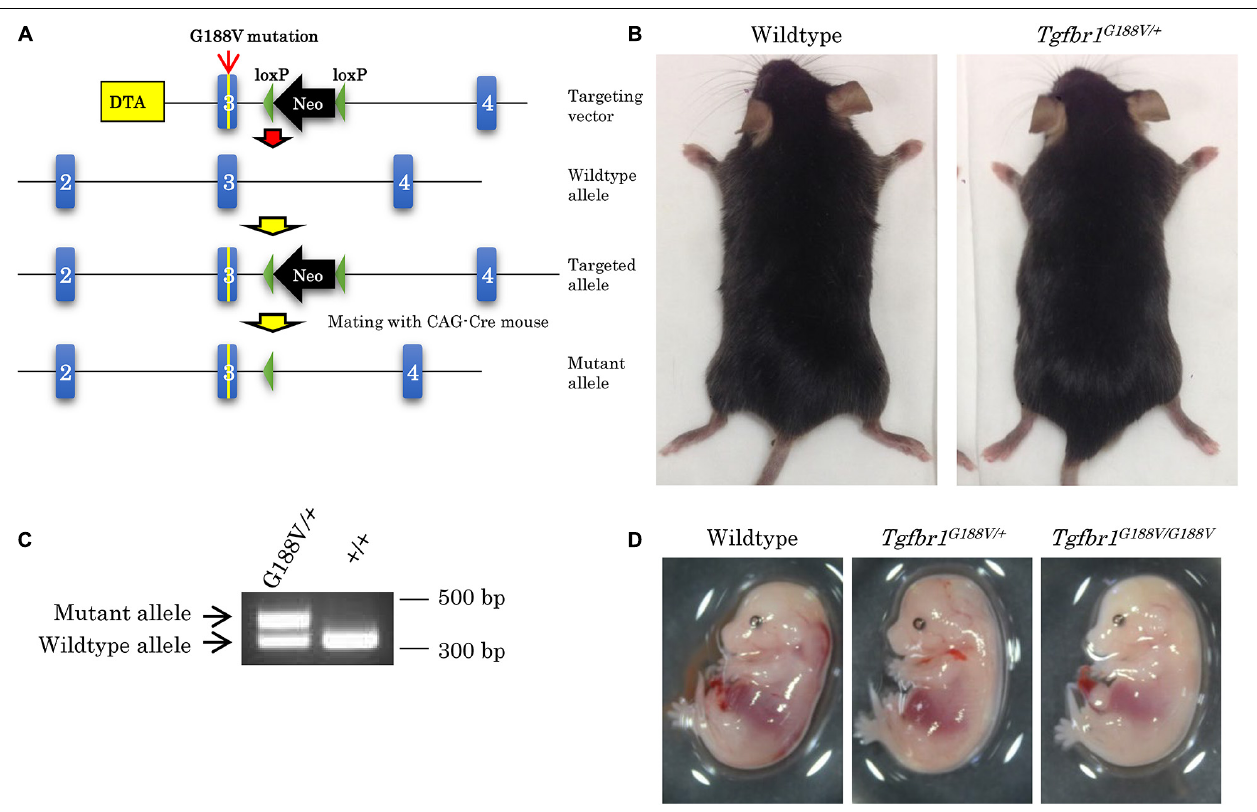
FIGURE 3 | Generation of knock-in mice with the Tgfbr1 G188V mutation. (A) Structure of the Tgfbr1 G188V mutant allele. (B) No clear differences in 6-week-old Tgfbr1 G 188 V / + mice. (C) PCR genotyping of genomic DNA using tail specimens collected from Tgfbr1 G 188 V / + and WT mice. (D) Embryos of WT, Tgfbr1 G 188 V / + , and Tgfbr1 G 188 V / G 188 V at embryonic day 14.5.